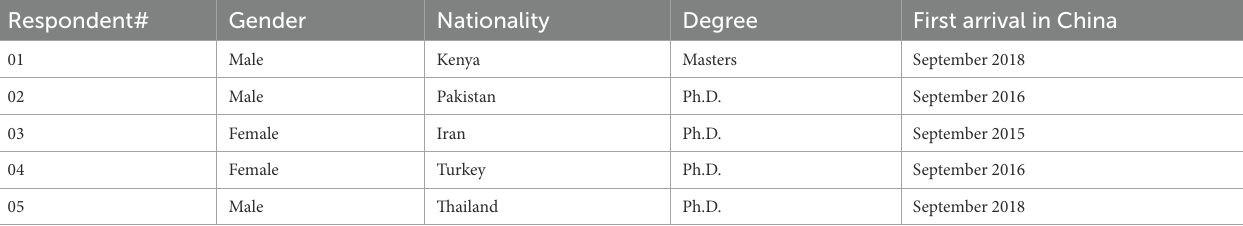
TABLE 1 Detail of international students who remained in China during the pandemic.